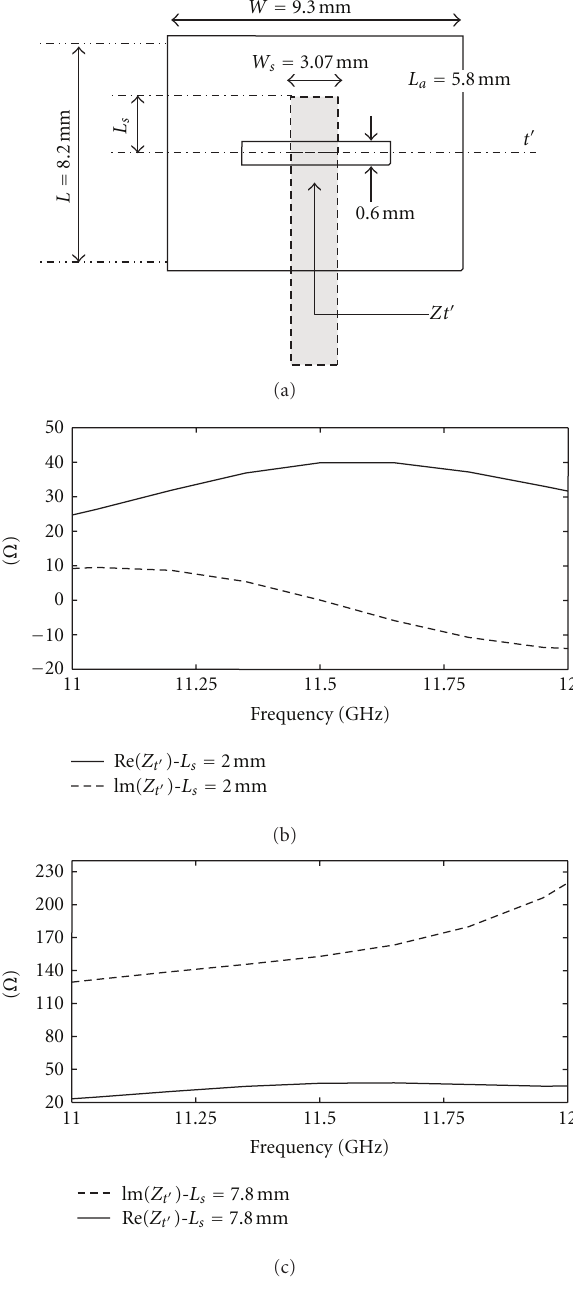
Figure 2: Synthesized aperture-coupled patch: (a) element layout; (b) simulated input impedance for L s = 2 mm; (c) simulated input impedance for L s = 7 . 8